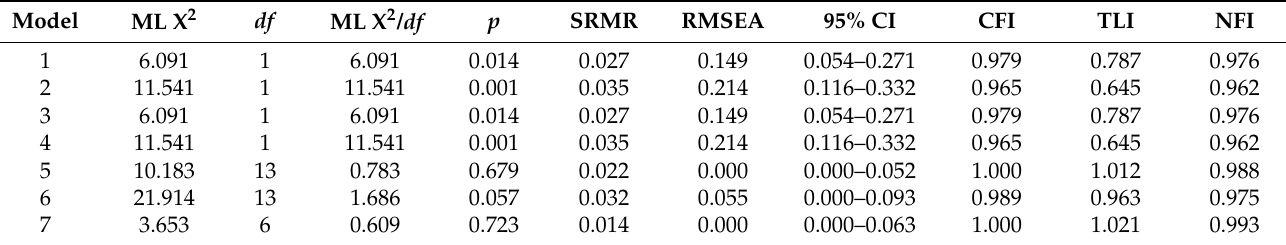
Table 6. Fit indices for alternative models.